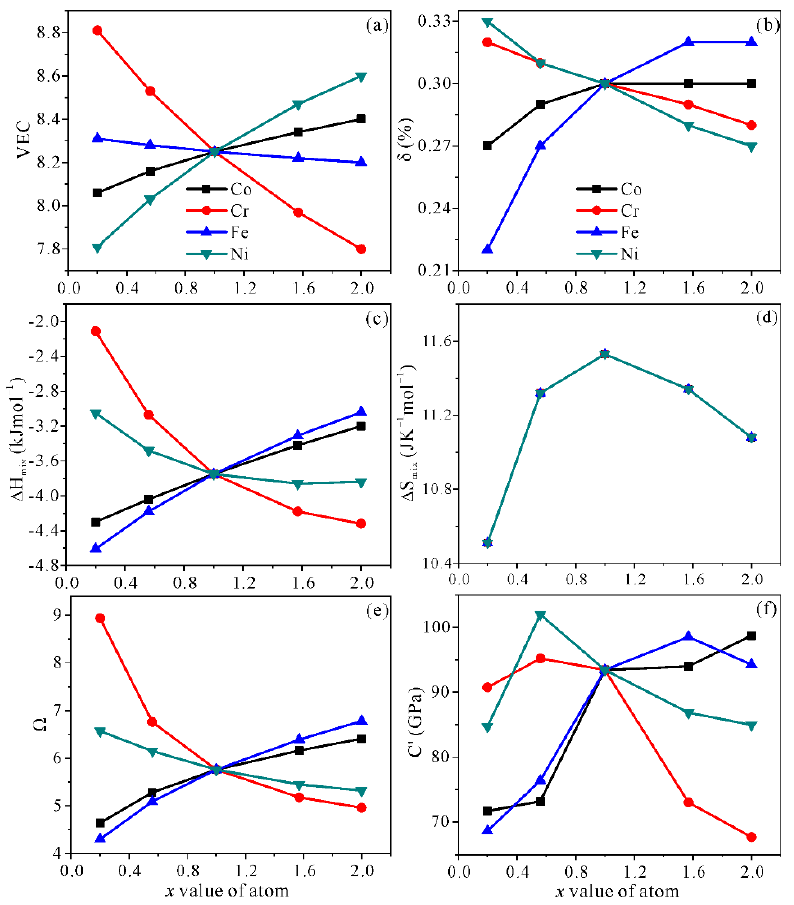
Figure 2. Structural stability parameters of Co-Cr-Fe-Ni HEAs with the x value of elements. ( a ) Valence electron concentration (VEC), ( b ) atomic size difference δ , ( c ) enthalpy of mixing ∆𝐻 𝑚𝑖𝑥 , ( d ) entropy of mixing ∆𝑆 𝑚𝑖𝑥 , ( e ) parameter Ω , and ( f ) tetragonal shear modulus c ′.